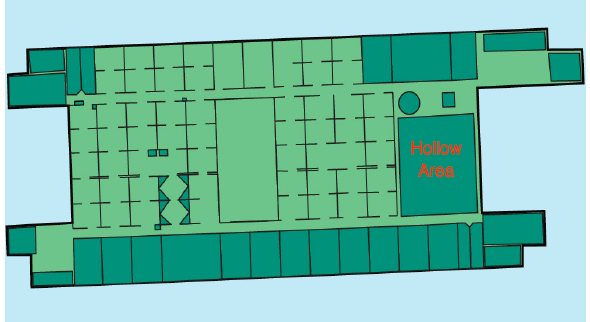
Figure 8. The floor plan of F7 in Building 3.